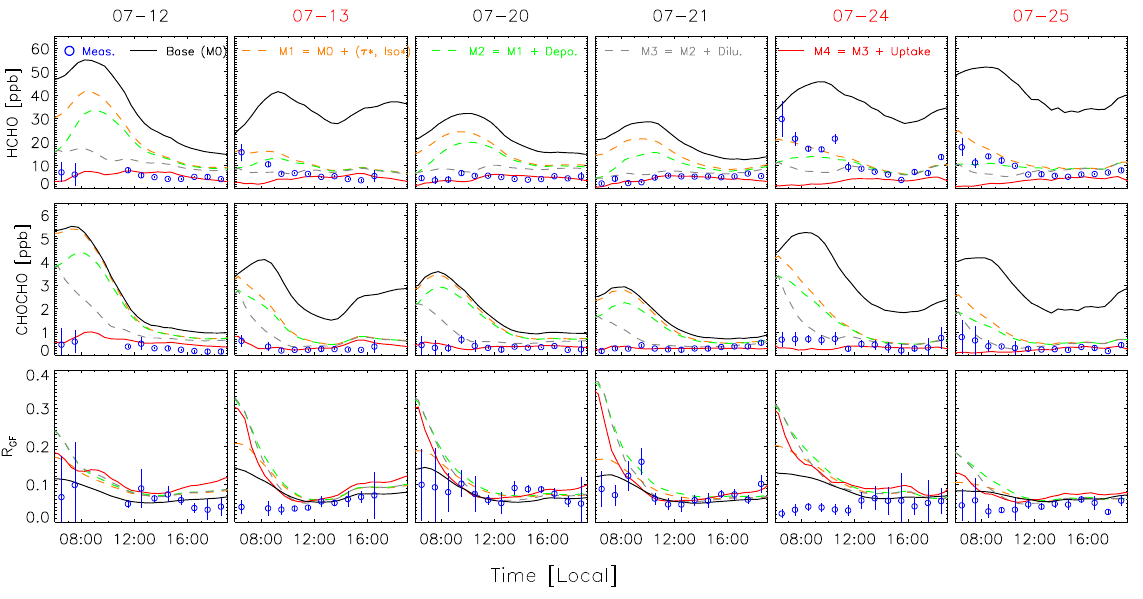
Figure 4. Sensitivity analysis of HCHO and CHOCHO simulation for the 6 cloud-free days during the PRIDE-PRD2006 campaign. Dates color coded in red are the days which were influenced by local combustion events. The blue dots are the measured concentrations with error bars indicating the 1 σ statistic error of the measurements. Symbols with color black, orange, green, gray, and red represent the modeled concentrations by model base case (M0), and M1–M4, respectively. Detailed model settings are described in Table 1 in the text.